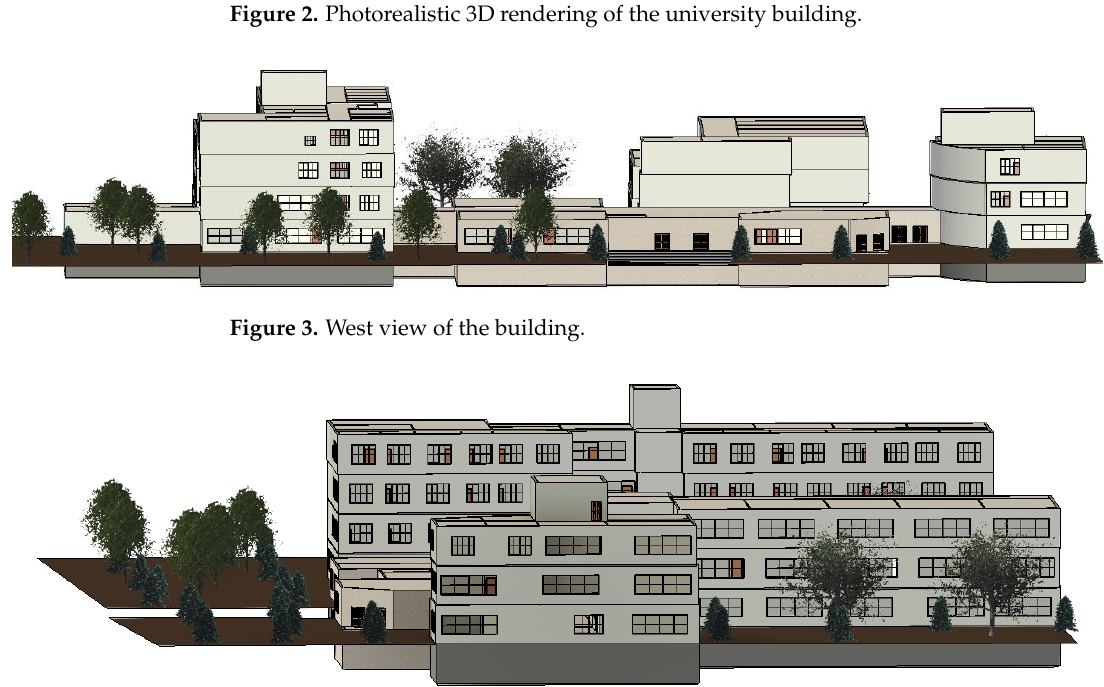
Figure 4. South view of the building.